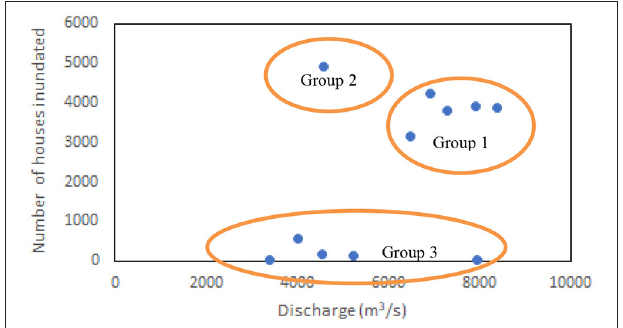
FIGURE 2 | Relationship between flow discharge at the Tategahana gauging station and the number of houses inundated above floor level in the watershed of the Chikuma River for 11 major floods since 1958.